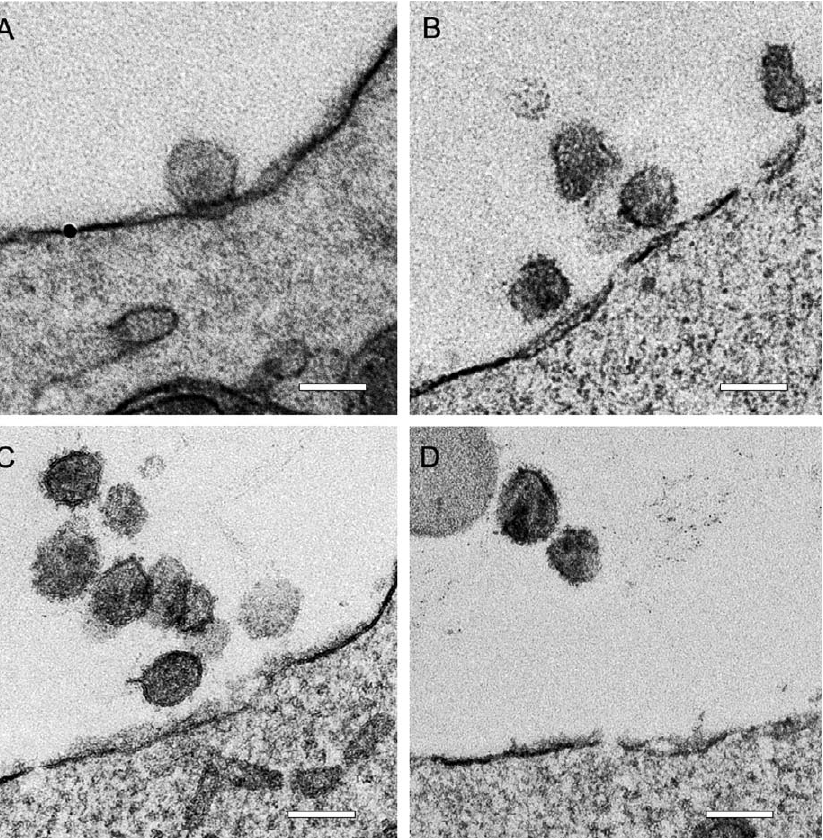
Figure 6. Analysis of Virus–Cell Contact under Different Conditions (A) Projection image of entry claw formed between SIV mac239 wild-type (full-length tail) and T cells fixed after incubation at 37 8 C for 3 h. (B) Projection image recorded from samples where SIV mac239 tail-truncated virus was fixed without warming to 37 8 C. While viruses could be occasionally found in close proximity of the cell membrane, no entry claw–like structures were observed. (C and D) Projection images recorded from cells incubated with SIV mac239 tail-truncated virus in the presence of 10 l M TAK779 or 5 l M C34 peptide, respectively. In both cases the viruses were incubated with cells for 3 h at 37 8 C, and no entry claw–like structures could be detected. Scale bars are 100 nm in all